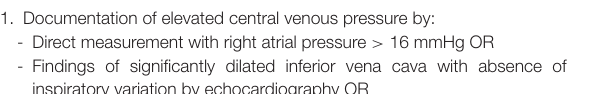
TABLE 1 | 2008 INTERMACS definition for right heart failure. Symptoms and signs of persistent right ventricular dysfunction Central venous pressure > 18 mmHg with a cardiac index < 2.0 L/min/m 2 Right Ventricular Assist Device Implantation OR use of inhaled nitric oxide or inotropic therapy for a duration of more than 1 week at any time after LVAD implantation